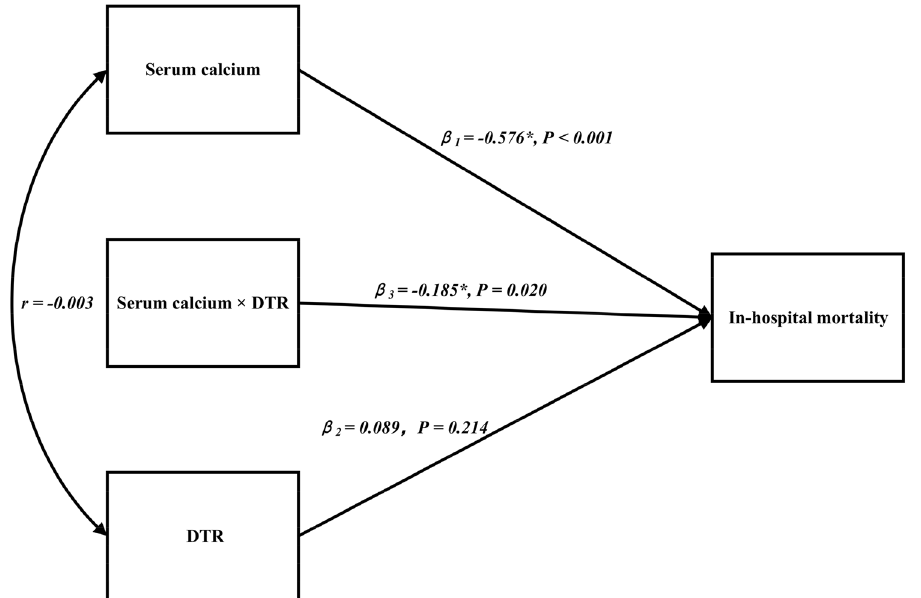
Figure 2. Model to show how different quartiles of admission diurnal temperature range (DTR) moderated the association between serum calcium concentration and in-hospital mortality of patients with acute myocardial infarction. β 1 = age, gender, current smoking, current alcohol use, diabetes mellitus, high-density lipoprotein cholesterol, uric acid, serum phosphate, serum potassium, left ventricular ejection fraction and left atrial diameter. β 2 = the independent effect of diurnal temperature range (DTR) on in-hospital mortality after adjusting for the above covariates. β 3 = the interaction effect of serum calcium concentration and DTR on in-hospital mortality after adjusting for the above covariates. r = correlation between serum calcium concentration and DTR. * P <